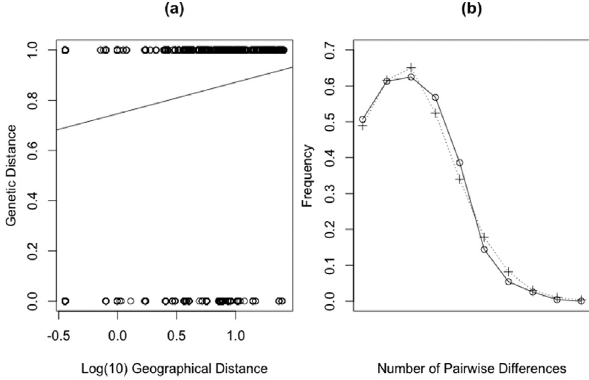
Figure 3 - Mantel test results. (a) Plot of Mantel test showing the relation- ship of genetic and geographic distances (r=0.18484, p=0.9995); (b) Mis- match distribution of mtDNA data for M. tridactyla . Observed (Obs, dashed line) and expected (Exp, solid line) average number of pairwise differences show a unimodal fashion, compatible with a recent population expansion